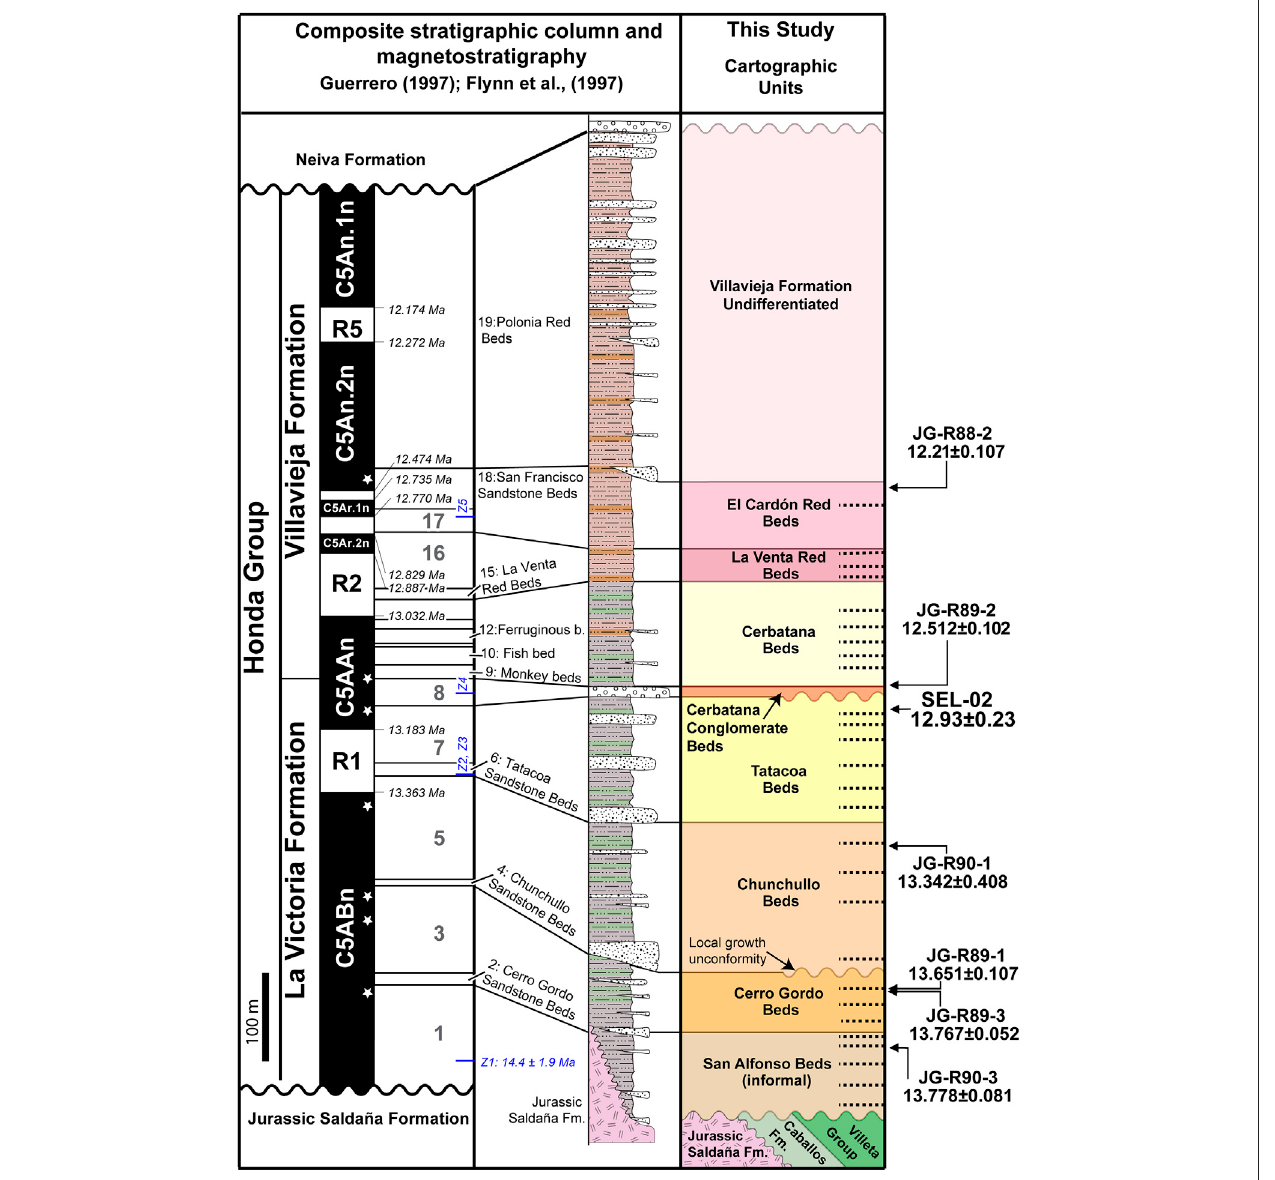
FIGURE 3 | Updated stratigraphic scheme for the Honda Group in the Tatacoa Desert. The original columns of Guerrero (1993, 1997), were consolidated into a single composite column where lenticular beds represent discontinuous sandstone units (i.e. found in only one stratigraphic column), and mudstones according to their color (Anderson et al., 2016). Magnetostratigraphy covers the C5An.1n-C5ABn interval, showing updated ages after Hilgen et al. (2012). Black arrows represent geochronologicalsamplesfromFlynnetal.(1997),bluearrowsrepresentmaximumdepositionalagesofAndersonetal.,(2016).Allsampleswerere-located(stars) in the stratigraphic column following the lithostratigraphic marker beds (horizontal dashed lines) of the geologic map ( Figure 4 ).